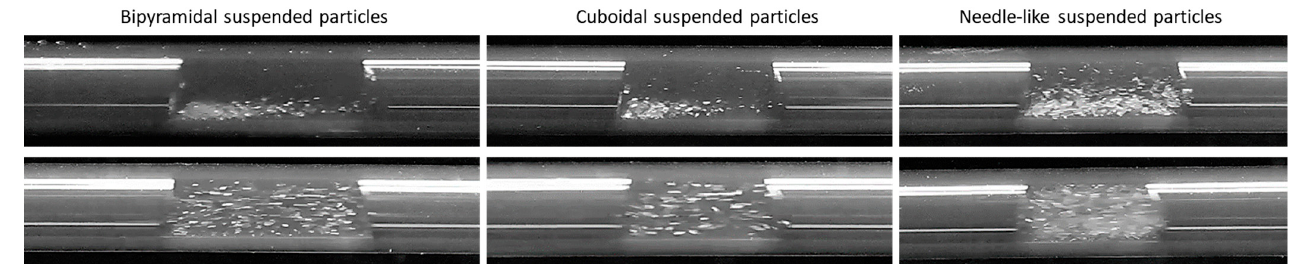
Figure 3. Images of bipyramidal ( left ), cuboidal ( middle ), and needle-like ( right ) shaped L -alanine particles in non-homogeneous ( top images, Q tot = 20 mL min − 1 ) and homogeneous ( bottom images, Q tot = 60 mL min − 1 ) suspended states inside a slug during experiments. Microscopic images showing the particle shapes are given in Figure 1. The recordings were taken after L tubing = 7.5 m. The ratio of gas and liquid volume fl ow rate was set to 1:1, and the fl ow direction was from the left to the right.